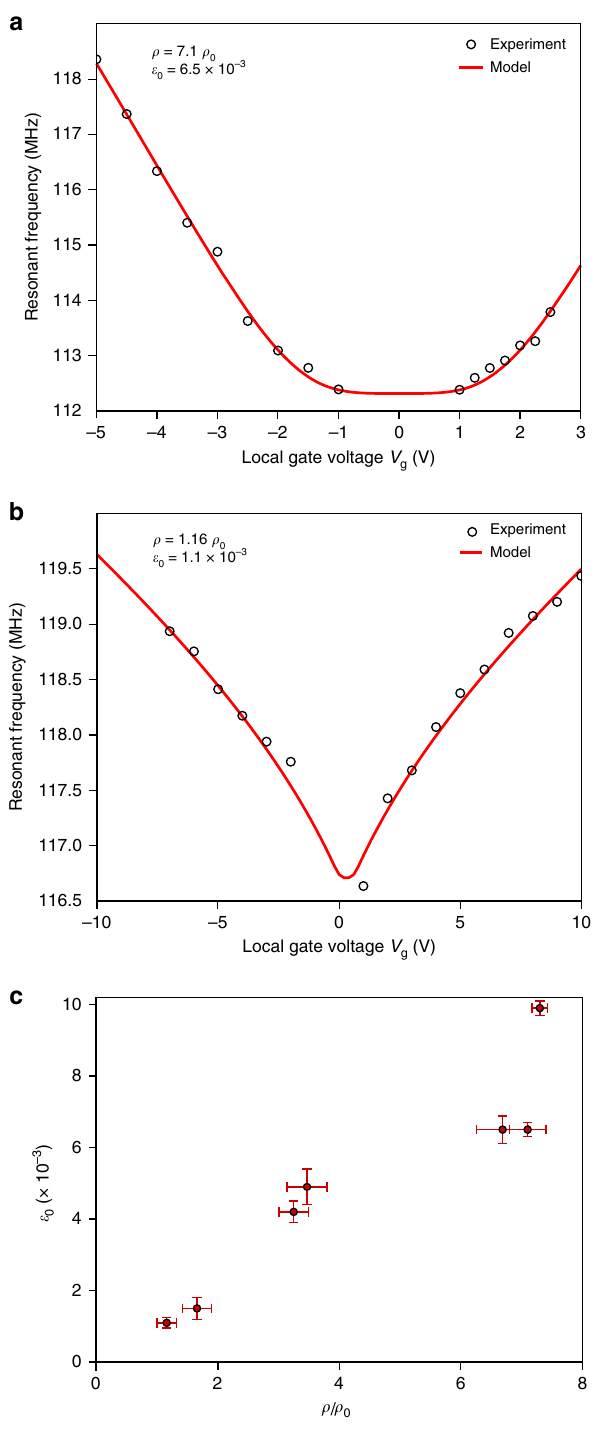
Fig. 3 Modulation of the resonant frequency of atomically thin resonators under tensile strain. a , b Experimentally measured resonant frequency as a function of local gate voltage V g (the black markers) for R1 and R2, respectively. The solid red lines are obtained by fi tting to the continuum mechanics model for membranes (described in Supplementary Note 6 and ref. 20 ) to determine the values of ρ 2 d and ε 0 for each device. As predicted by the model, higher values of built-in strain result in a concave curvature (R1), while the curvature is convex for lower built-in strain (R2). c Overview of the extracted mass density and built-in strain for seven MoS 2 NEMS resonators. The built-in strain is higher for resonators with higher mass density, indicating that the presence of contamination induces strain on the MoS 2 membrane. Error bars represent SD based on the precision